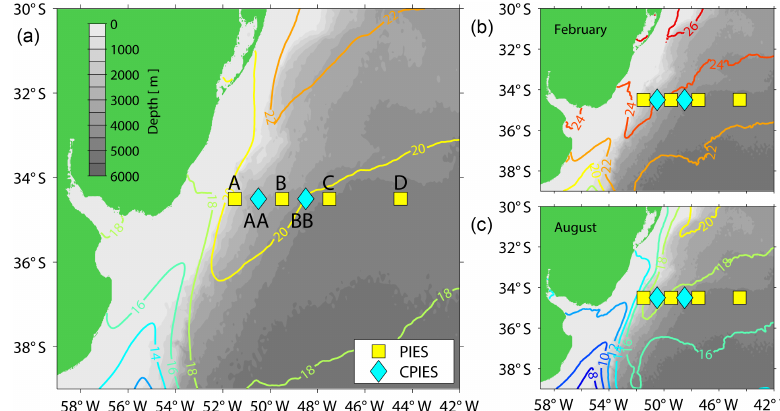
Figure 1. Map illustrating the location of the moored instruments used in this study. Instrument types are noted in the legend; site names for the original PIES (yellow squares) are “A” through “D” from west to east; the newer CPIES (cyan diamonds) site names are “AA” and “BB”, also from west to east. Filled contours indicate bottom topography from the Smith and Sandwell (1997) data set. Color contours indicate the time-mean sea-surface temperature ( ◦ C) from 2009–2015 from the GHRSST MUR reanalysis SST data product (see Chin et al., 1998; see also https://mur.jpl.nasa.gov/multi_resolution_analysis.php). The smaller panels on the right show the monthly mean SST maps from 2009–2015 for February (top) and August (bottom) to illustrate the latitudinal range through which the Brazil–Malvinas Confluence shifts during the year. Table 1. Nominal locations, depths, and initial deployment dates of the PIES and CPIES moorings discussed in this paper. Note: the first instrument at Site B was a CPIES, but it was replaced with a PIES in July 2011. Site Instrument Nominal Nominal Nominal Date of